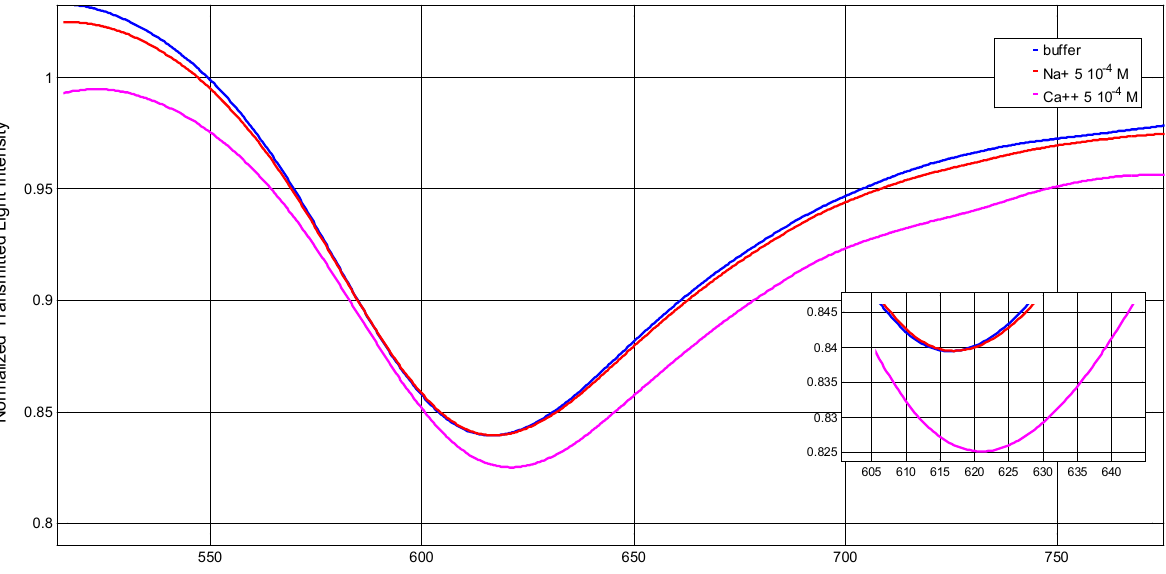
Figure 4. SPR transmission spectra obtained on DFO-SAM-POF sensor for two metal ions: Na + and Ca 2+ . For comparison, the spectrum of 0.5% HNO reported. Inset: Zoom of the resonance wavelengths